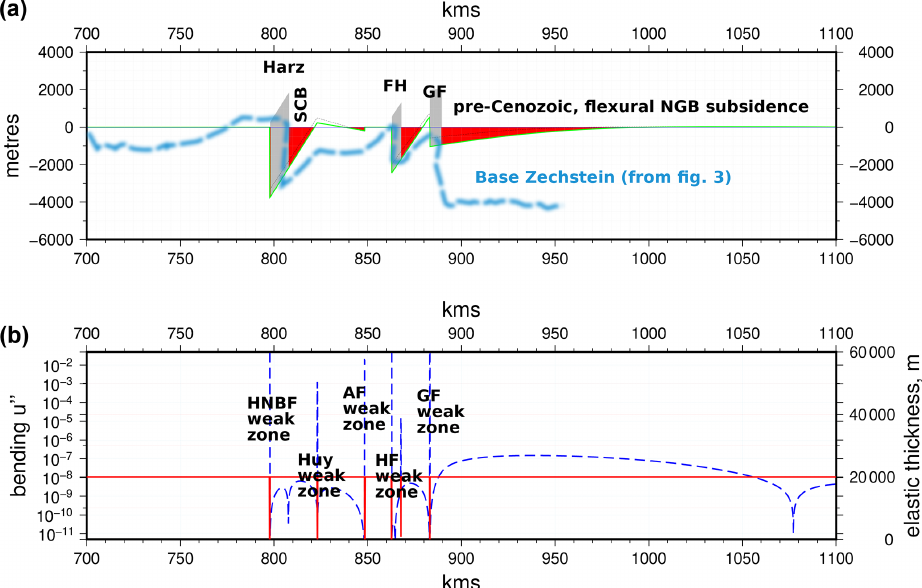
Figure 7. Flexure model of broken central European lithosphere during Late Cretaceous compression. (a) Flexural subsidence of an originally horizontal marker within the lithosphere. The black dashed line is the initial subsidence due to static thrust load (grey shade), and the green solid line is the final subsidence including iteratively calculated basin fill (red shading). The light blue dashed line shows base Zechstein unconformity for comparison. Model includes a Harz, Flechtingen, and Gardelegen (Calvörde) “load” and breaks in the lithosphere. (b) Bending (blue dashed) and elastic thickness (red dashed) curves for the model. Elastic breaks at the HNBF, Huy, AF, HF, and GF basement faults are shown. Abbreviations: HNBF – Harz Northern Boundary Fault; AF – Allertal Fault; HF – Haldensleben Fault; GF – Gardelegen Fault; SCB – Subhercynian Cretaceous Basin.